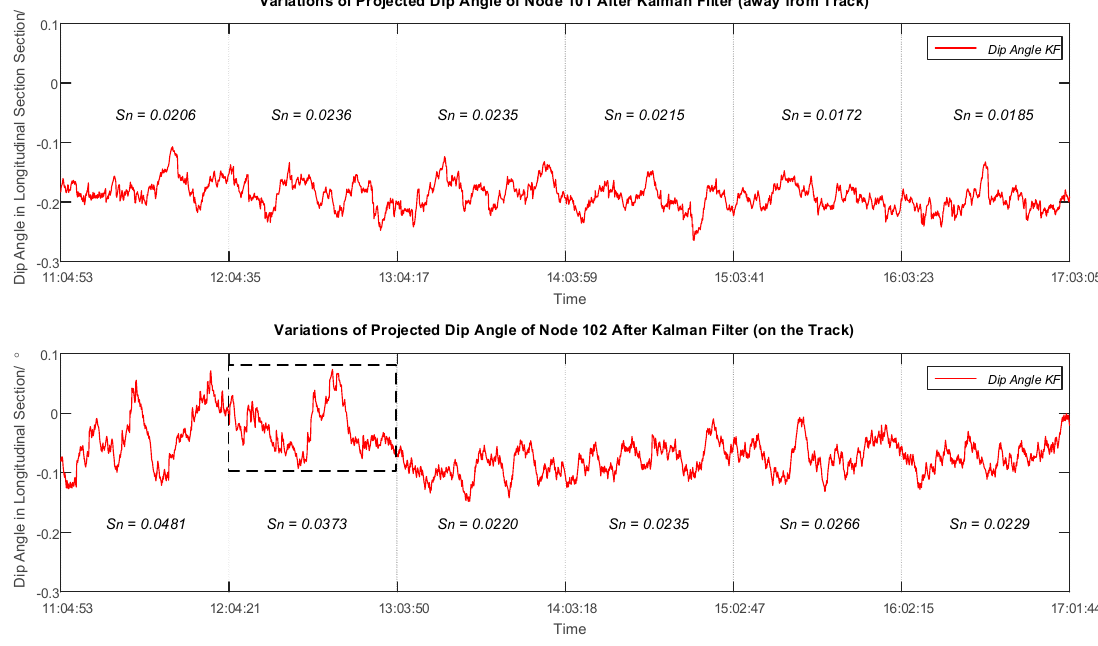
Figure 11. Plots of Dip Angle Variations after Kalman Filter of Sensor Node 101 (away from Track) and Node 102 (on the Track) in the Longitudinal Section over the Observing Day with Hourly Standard Deviations. The values of standard deviations are mostly between 0.0172 and 0.0266, and the two exceptions appear in the first two hours for Node 102 indicating a disturbance of the data.